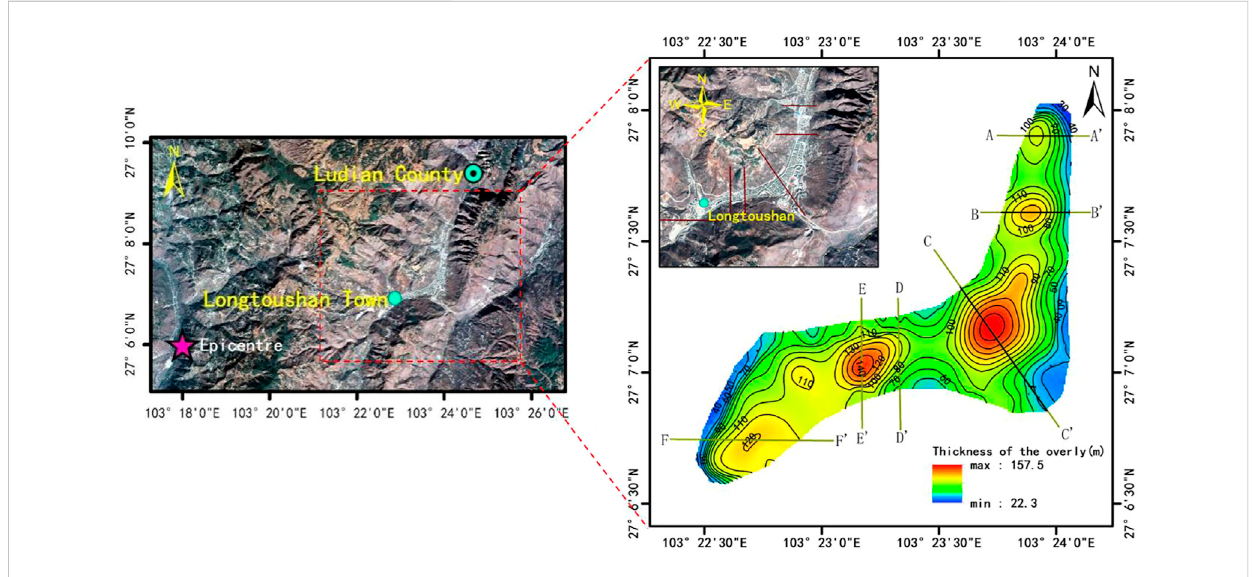
FIGURE 6 Location of the basin and locations of the selected pro fi les in the